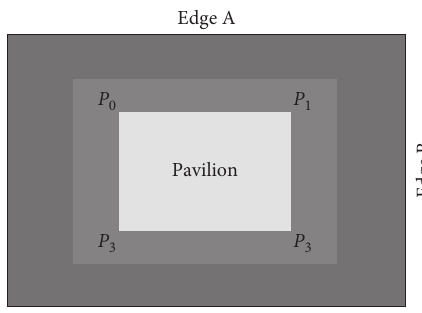
Figure 6: Black rectangular frame border of the photo mark card.